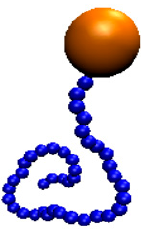
Figure 1. Model of a shape amphiphile (P n –H), in which the blue beads and the orange bead represents the hydrophobic polymer tail (P n ) and the hydrophilic nanoparticle (H), respectively.